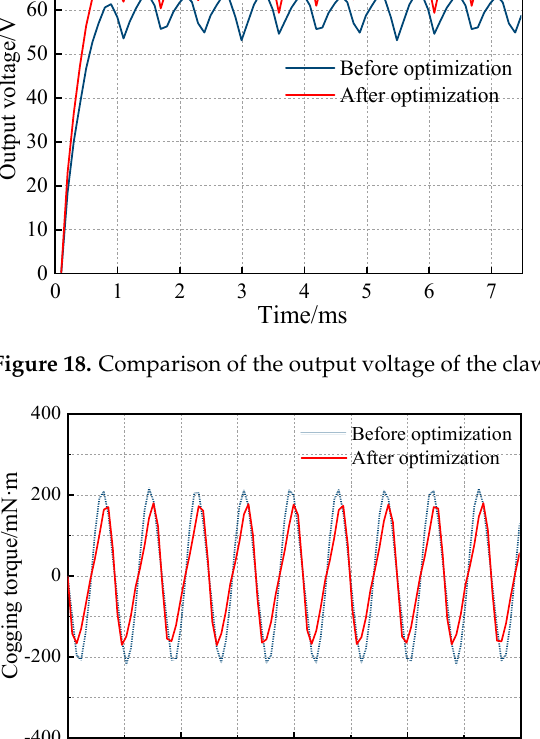
Figure 19. Comparison of cogging torque of claw pole rotor before and after optimization.